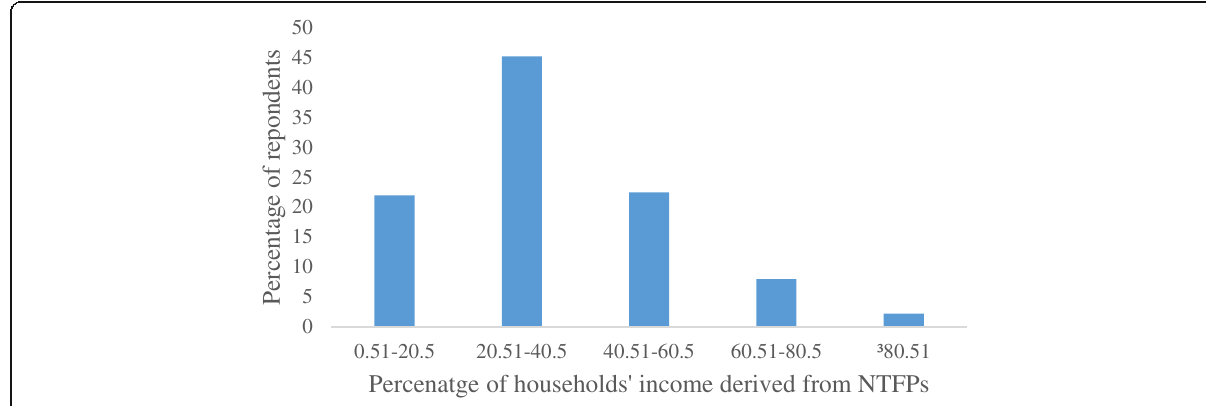
Fig. 5 Percentage contribution of non-timber forest products to the total household income